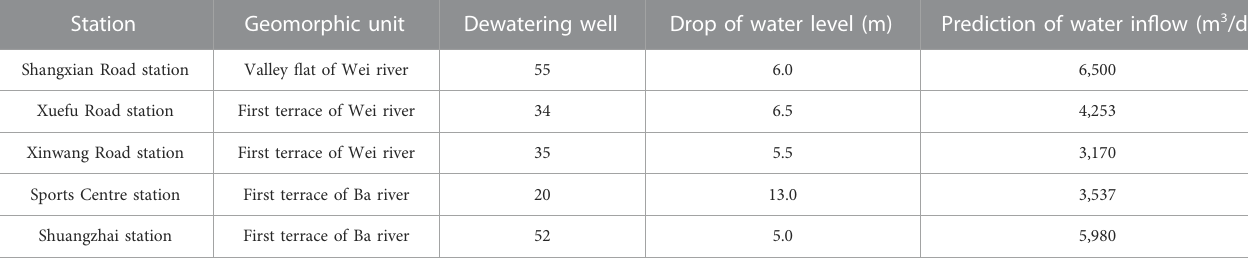
TABLE 2 Estimation of water in fl ow of metro stations pit on Line 14.